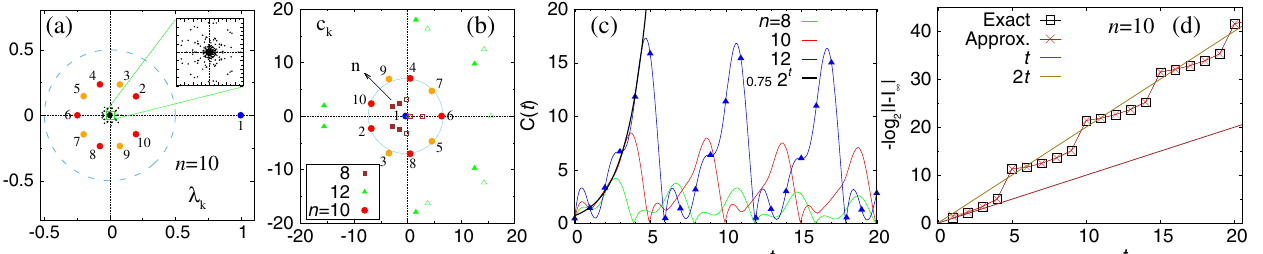
FIG. 14. Slower convergence than − ln j λ 2 j for the S with OBC and the XY gate due to a phantom eigenvalue [dashed blue circle in (a)]. (a) Complex spectrum of M for n ¼ 10 (even sector with 512 eigenvalues). (b) Expansion coefficients c k [Eq. (30)]. Numbered points correspond to respective eigenvalues in panel (a); the five full red circles (2,4,6,8,10) are n= 2 leading terms contributing to I − I ∞ . The size of j c k j grows exponentially with n . (c) Sum C ð t Þ ¼ 4 t j triangles are at physical integer t ). (d) Comparison of the exact purity and the approximation with n= 2 terms from panel